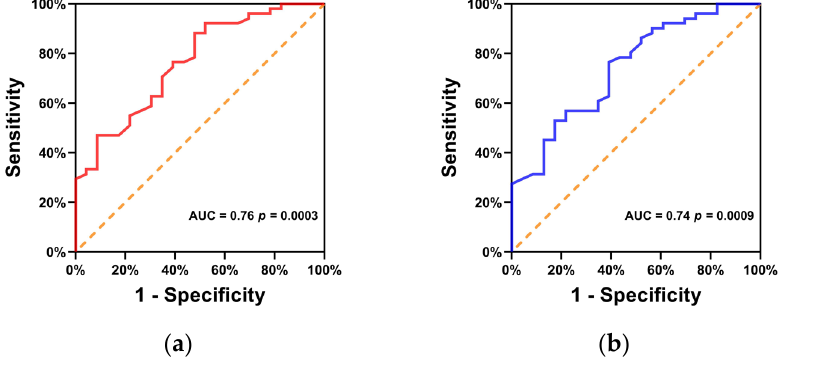
Figure 4. ROC curve analysis of SUVmax ( a ), SUVmean ( b ) and TLG ( c ) for predicting PD-L1 status. Table 3. ROC curve analysis of the predicting role of PD-L1 status by metabolic parameters.